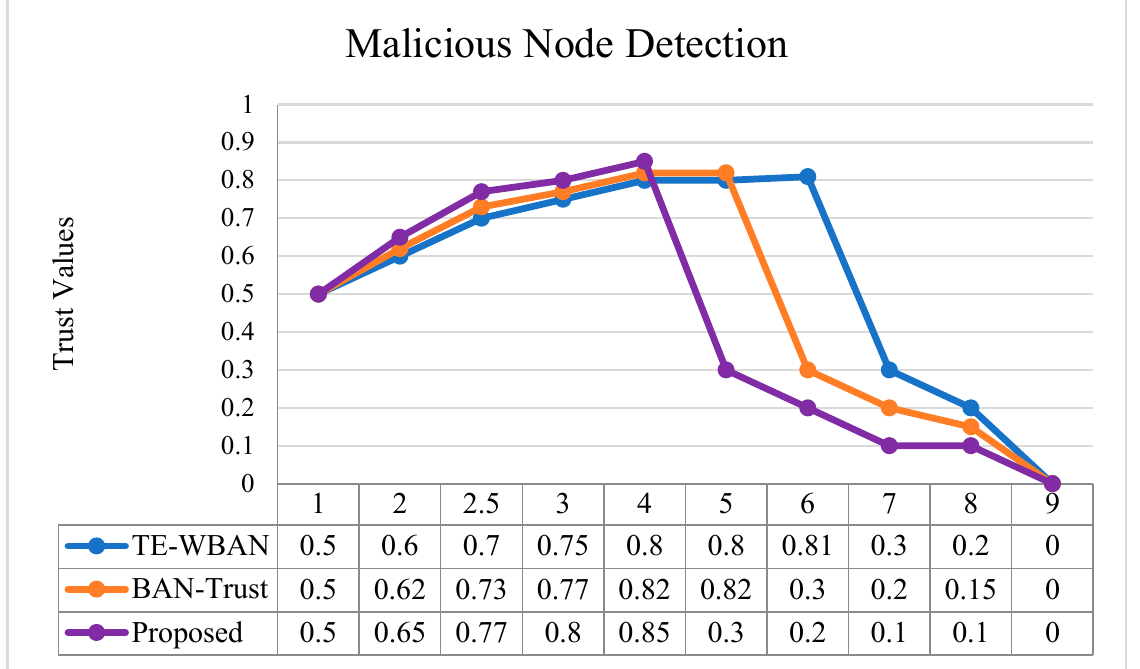
Figure 4. Malicious Node Detection.